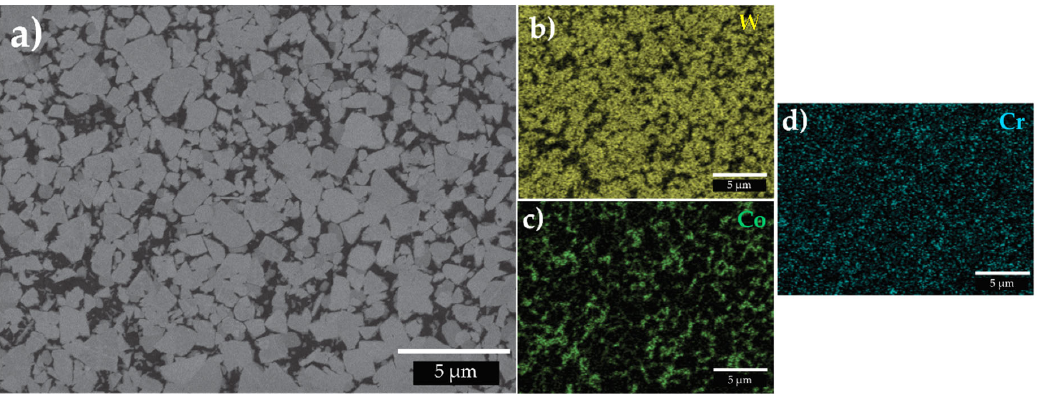
Figure 5. Outer region ( a ) representative microstructure. EDS mapping concentration for ( b ) W, ( c ) Co and ( d ) Cr.